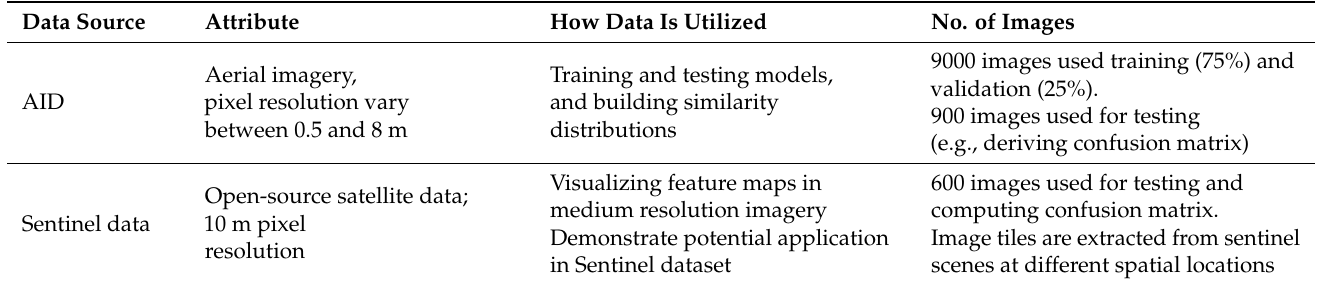
Figure 3. A conceptual framework for unclassified images/scenes comparison. Earth Movers Distance (EMD)(X, X’), EMD(Y, Y’), and EMD(Z, Z’) denote within-landscape comparison, while EMD(X, Y), EMD(Y, Z), and EMD(Z, X) represent between-landscape comparison. Table 2. Data types and specific